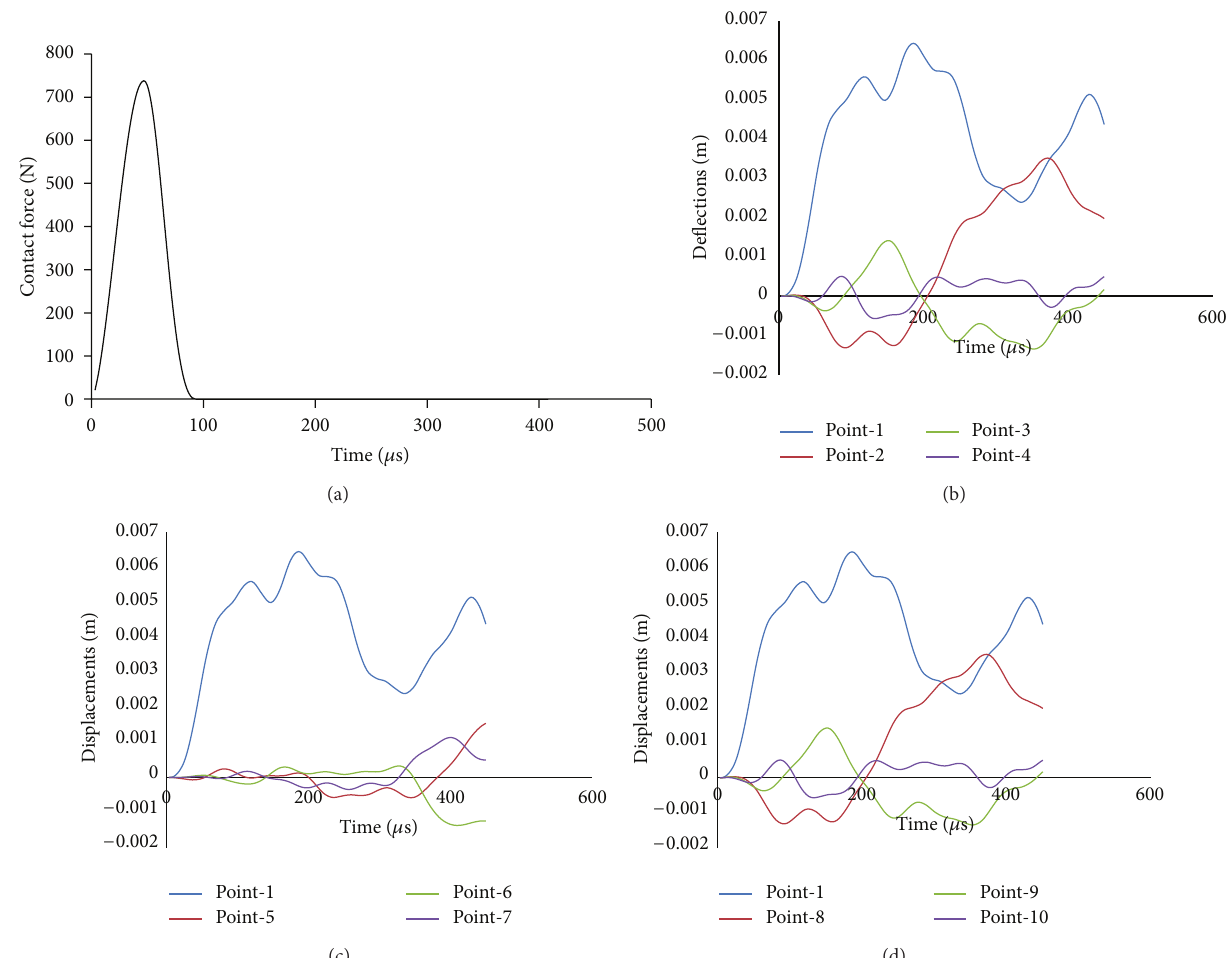
Figure 5: Impact response of clamped cross ply (CL/CP) composite hypar shells for impact velocity 2m/s.